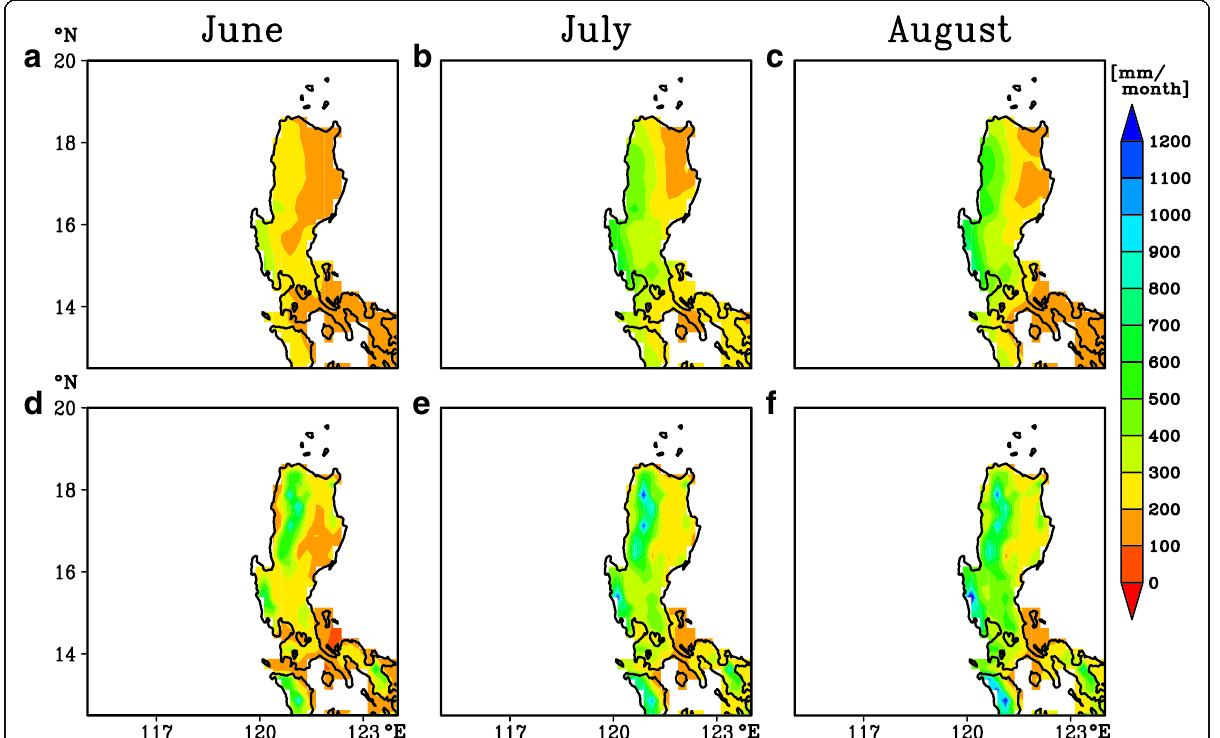
Fig. 3 Climatological monthly terrestrial precipitation (mm month − 1 ) from 1982 to 2007 over domain 2, calculated by the CTL simulation ( d – f ) and compared with the APHRODITE dataset ( a – c